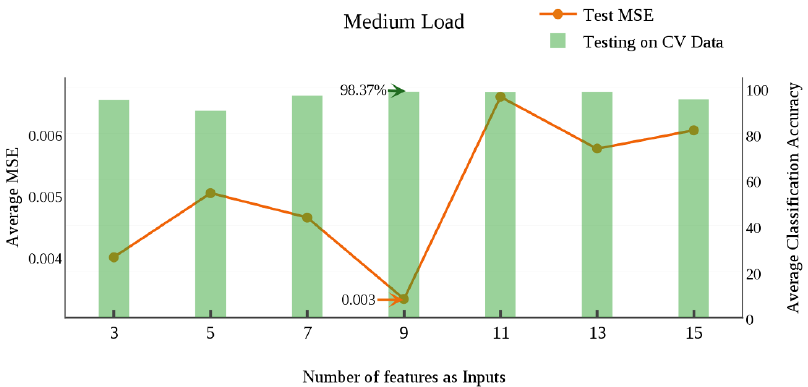
Figure 10. Variation of average classification and MSE with a number of features as inputs in Medium Load. Appl. Sci. 2017 , 7 , x FOR PEER REVIEW